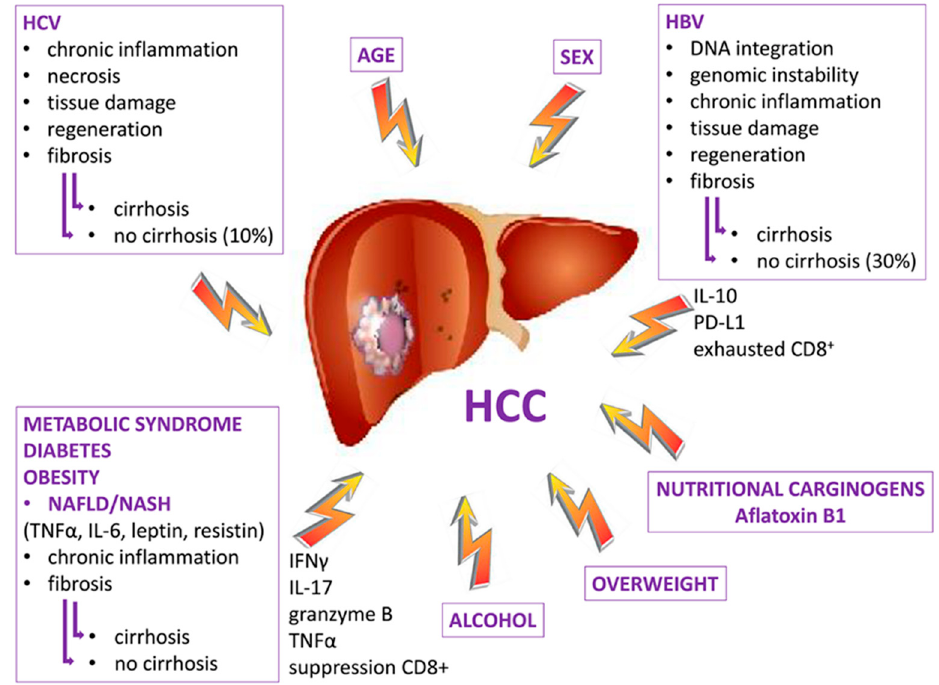
Figure 3. Cooperating risk factors for HCC onset. Factors with a viral and non-viral etiology may be responsible for the onset of the HCC by releasing specific mediators that lead to the formation of an inflammatory microenvironment that predisposes to the formation of fibrosis which can develop into cirrhosis which in some cases is not an essential condition for the development of HCC.